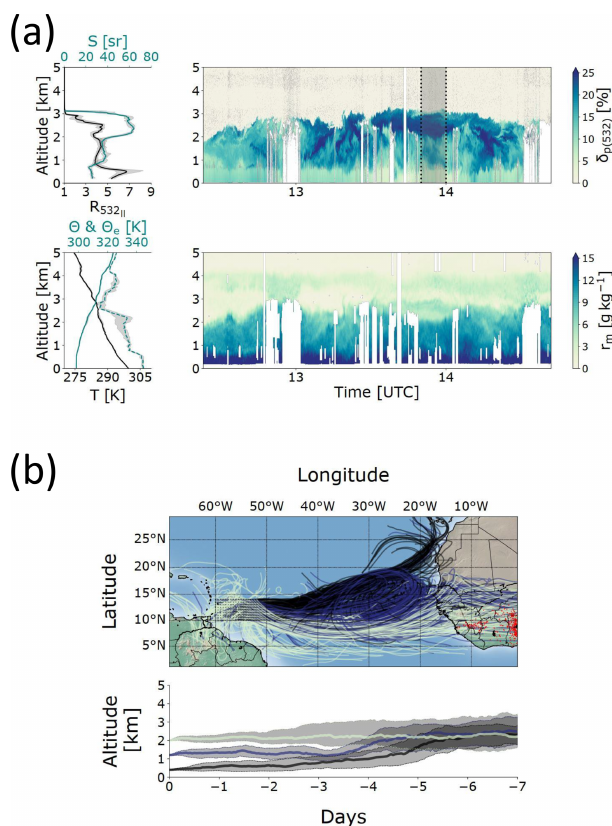
Figure 3. (a) Overview of measured profiles during the HALO- 0130 research flight as measured by lidar and dropsondes. The left panels show median profiles of 532nm backscatter ratio ( R || , black), lidar ratio ( S , teal), temperature ( T , black), equivalent po- tential temperature ( (cid:50) e , teal, dashed) and potential temperature ( (cid:50) , teal, solid) during the flight. The profiles of R || and S refer to the gray shaded regions in the respective right panel. Shaded regions indicate the inter-quartile region. The right panels show the mea- sured profiles of the 532nm particle linear depolarization ratio ( δ p ) and water vapor mass mixing ratio ( r m ). (b) The 7d backward trajectories of the air mass that was sampled during the HALO- 0130 research flight. Trajectories are indicated for starting points in 0.4km (black), 1.2km (blue) and 2.0km (light green) altitude that are regularly distributed over the research areas (0.5 ◦ spacing) and are calculated using the Hybrid Single Particle Lagrangian Inte- grated Trajectory model (HYSPLIT). Red markers indicate detected thermal anomalies related to active fires detected by the Visible In- frared Imaging Radiometer Suite (VIIRS) 7d before the respective research flights. The lower panels show the median altitude of the backward trajectories. Shaded regions indicate the inter-quartile re-